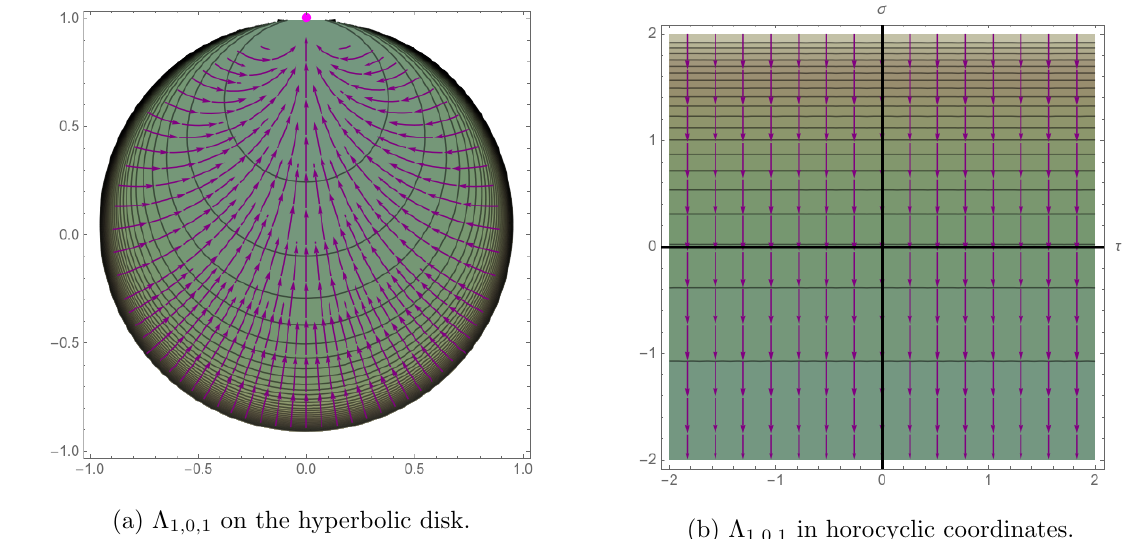
Figure 10. Contour plot of the canonical lightlike Hesse function (cid:3) 1 ; 0 ; 1 and of its gradient (cid:13)ow. The values of the function decrease from lightest brown to darkest green. In the (cid:12)gure on the left (which coincides with (cid:12)gure 4), the single point on the conformal boundary of D where the function tends to zero is shown as a red dot. The gradient vector (cid:12)eld is shown in purple. The (cid:12)gure to the right shows only a portion of the ( (cid:28); (cid:27)